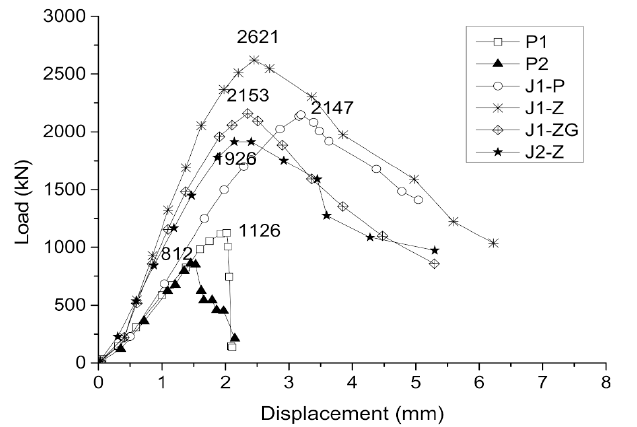
Figure 10. Load–displacement curves of the specimens.